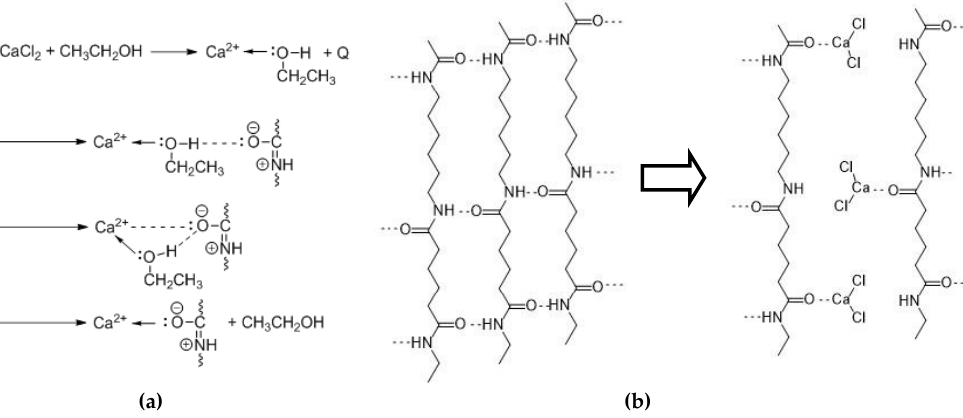
Figure 1. Proposed complexation mechanism of polyamide 6.6 (PA 6.6) in CaCl 2 /EtOH/H 2 O solvent: ( a ) Complex formation; ( b ) Disruption of hydrogen bonds in PA 6.6 in the presence of CaCl 2 according to [24].